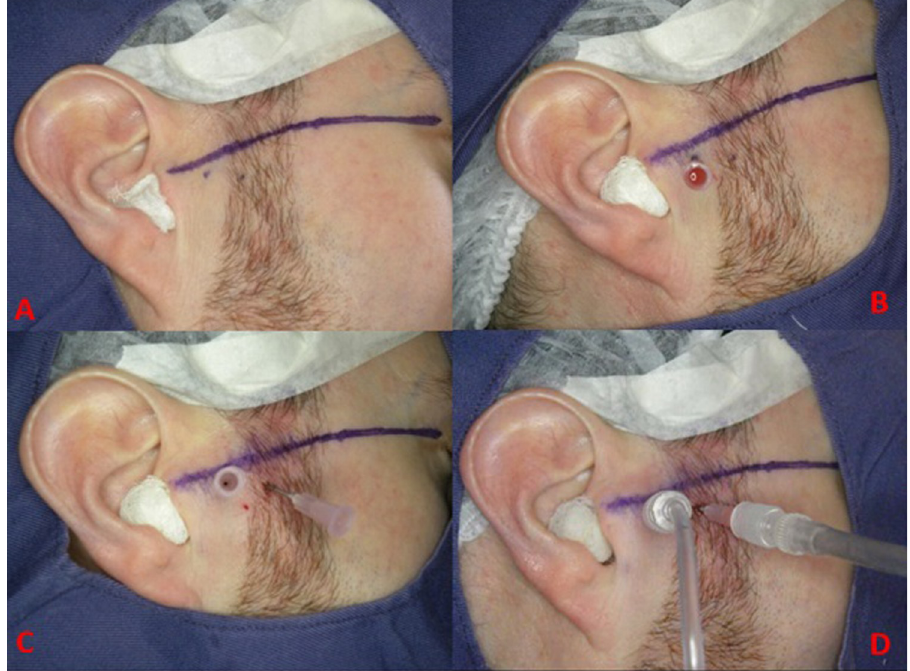
Fig 1. A: reference line and the two points for the insertion of the needles. B: first needle inserted. C: second needle inserted. D: first needle connected with syringe and the second needle connected to a vacuum pump. The physiological